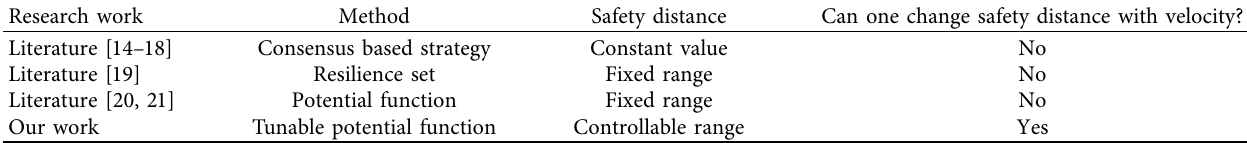
Table 1: The comparisons between related works and our